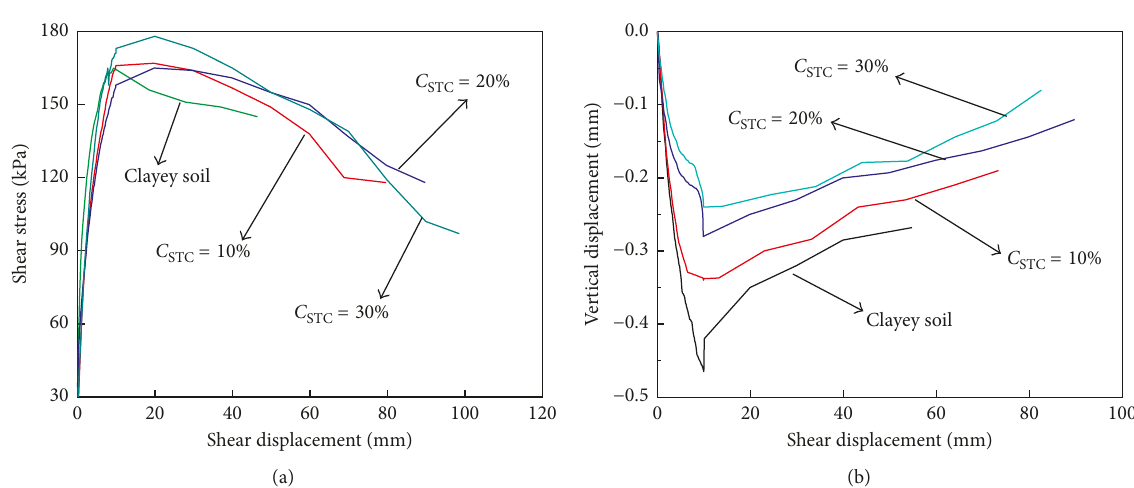
Figure 12: Plots of shear stress and vertical deformation of mixtures against shear displacement for mixtures under vertical pressure of 200kPa. (a) Shear stress versus shear displacement. (b) Vertical displacement versus shear